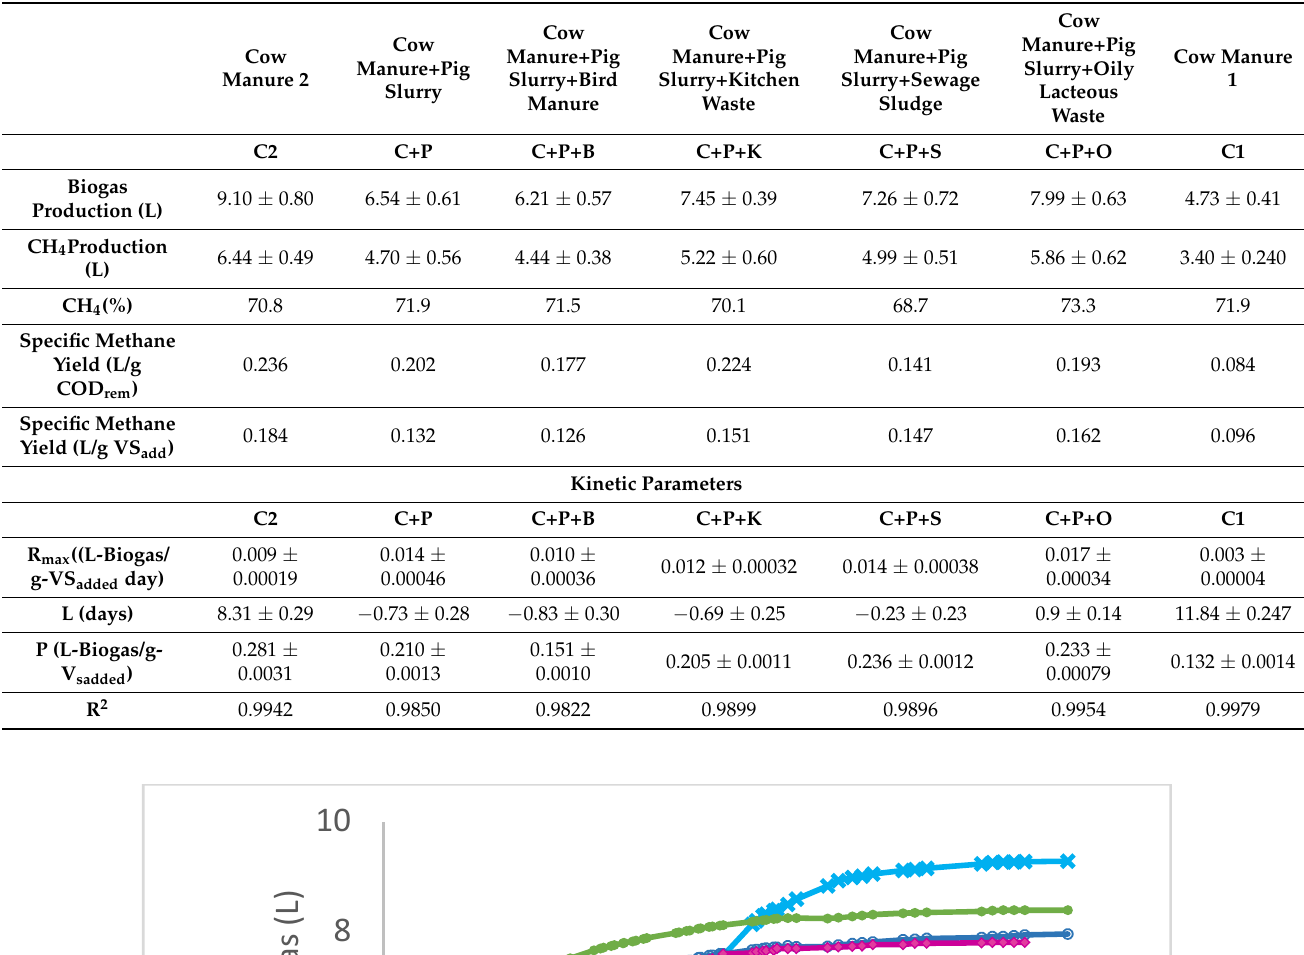
Table 5. Biogas productions and yields in AcoD assays in 60-days operation. Parameters from the kinetic modelling accordingly to modified Gompertz Equation (2).